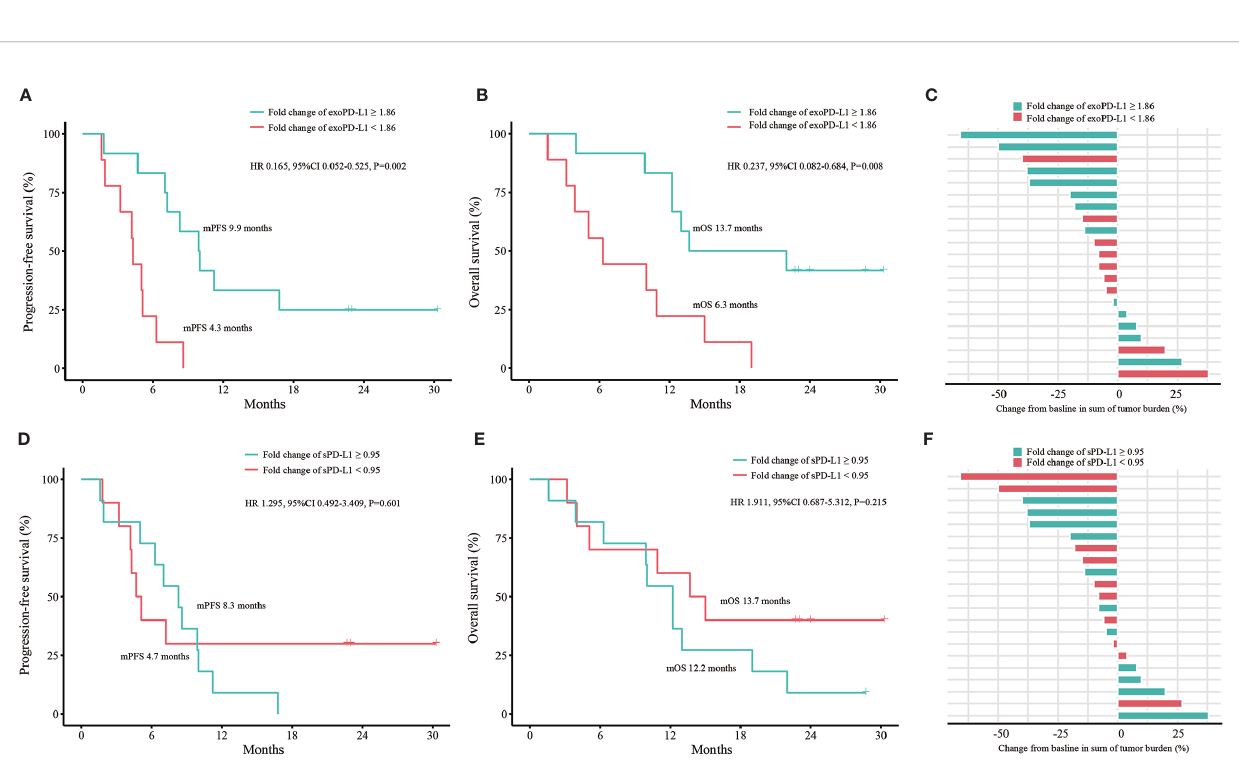
FIGURE 4 | Ef fi cacy and OS analyses based on fold change of exoPD-L1 or sPD-L1 expression in the 21 NSCLC cohort. (A) PFS analysis based on fold change of exoPD-L1 expression. (B) OS analysis based on fold change of exoPD-L1 expression. (C) bOR of each patient strati fi ed by fold change of exoPD-L1 expression. (D) PFS analysis based on fold change of sPD-L1 expression. (E) OS analysis based on fold change of sPD-L1 expression. (F) bOR of each patient strati fi ed by fold change of sPD-L1 expression. OS, overall survival; exoPD-L1, exosomal PD-L1; sPD-L1, soluble PD-L1; PFS, progression-free survival; bOR, best objective response; HR, hazard ratio; CI, con fi dence interval. P values were calculated by log-rank test.